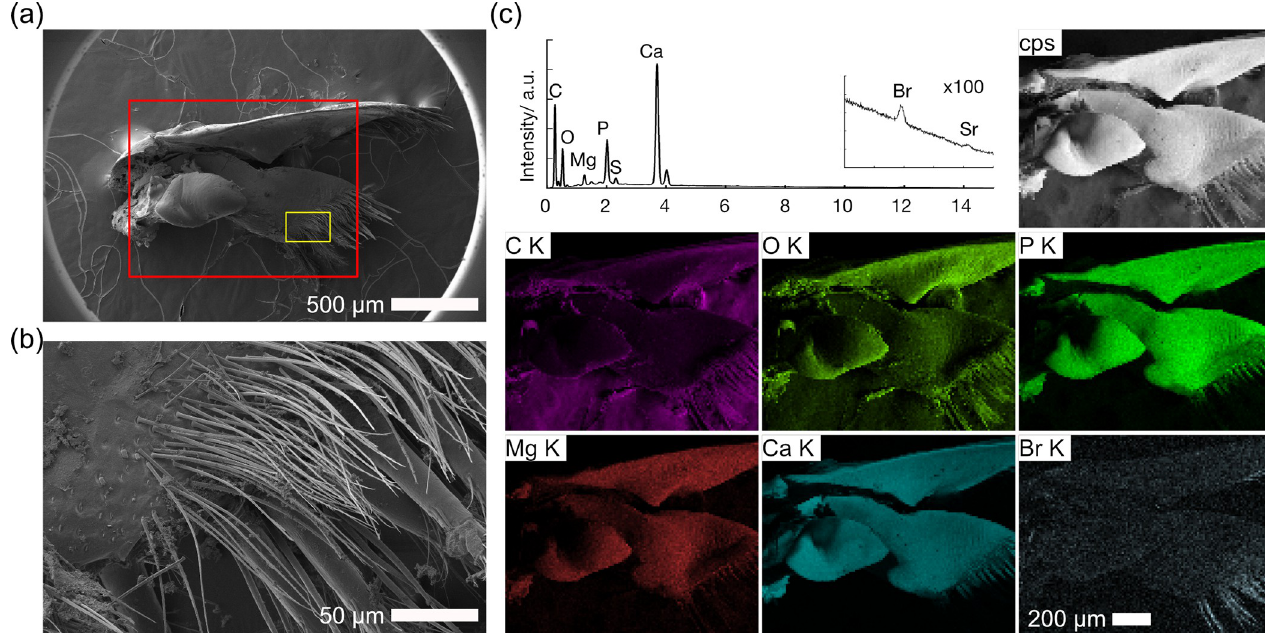
Fig 6. SEM/EDS images of maxilla 2 of Hirondellea gigas . a) Low-magnification SEM image. b) Magnified image of the yellow rectangle in part (a). c) EDS elemental mapping and sum spectrum of the red rectangle in part (a).